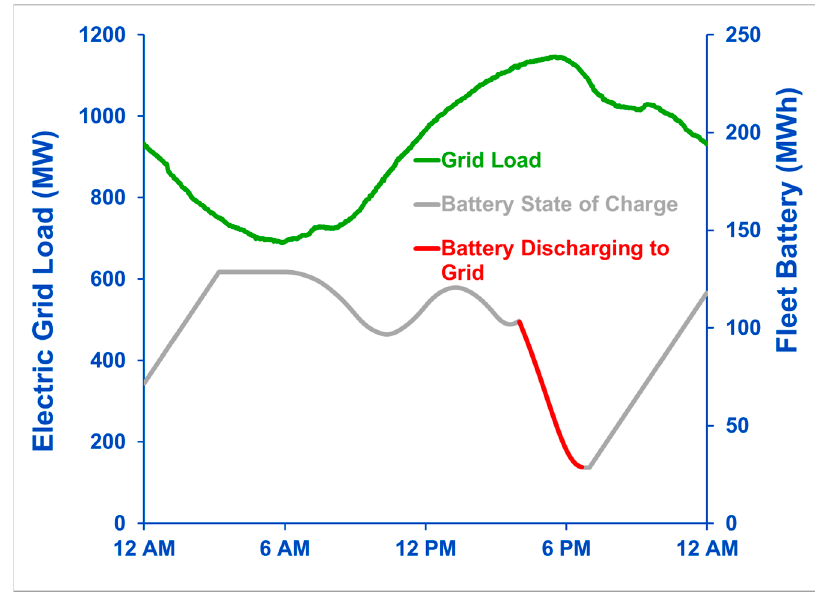
Figure 3. Charge/discharge profile of EV fleets to support grid load.